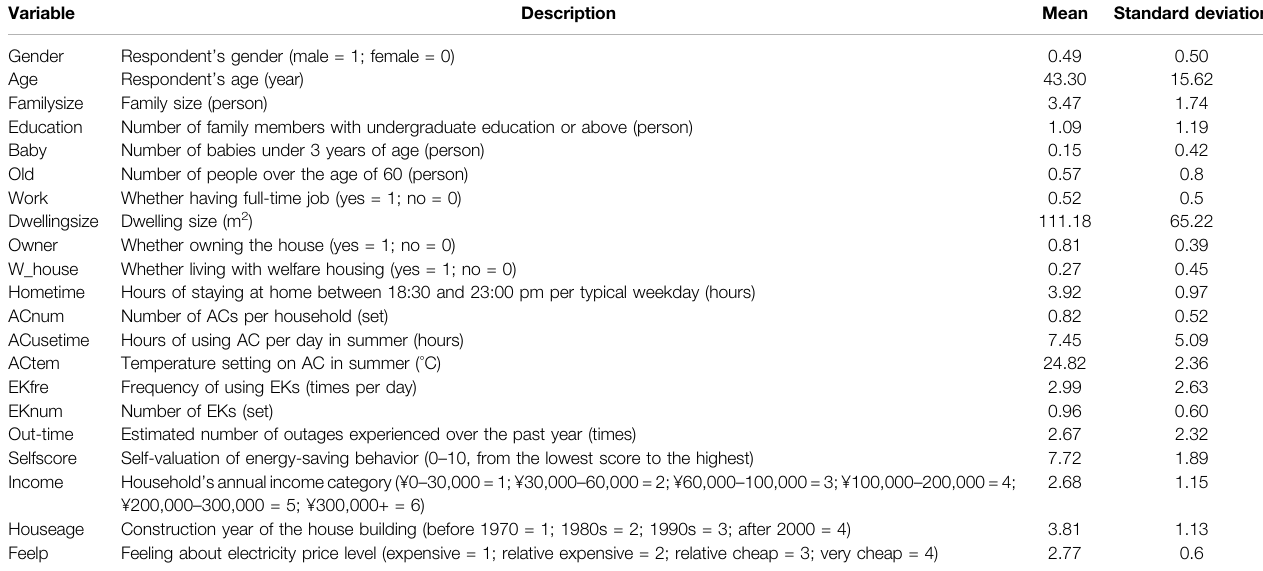
TABLE 2 | Summary statistics. Variable